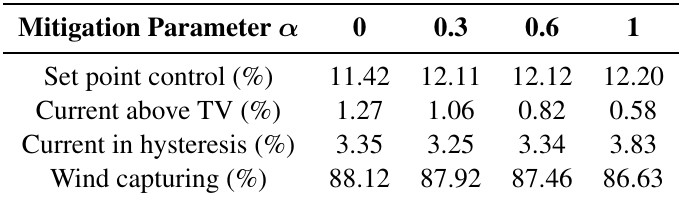
Table 9. Simulation results: controlled relief of control action, PD (Proportional Derivative)